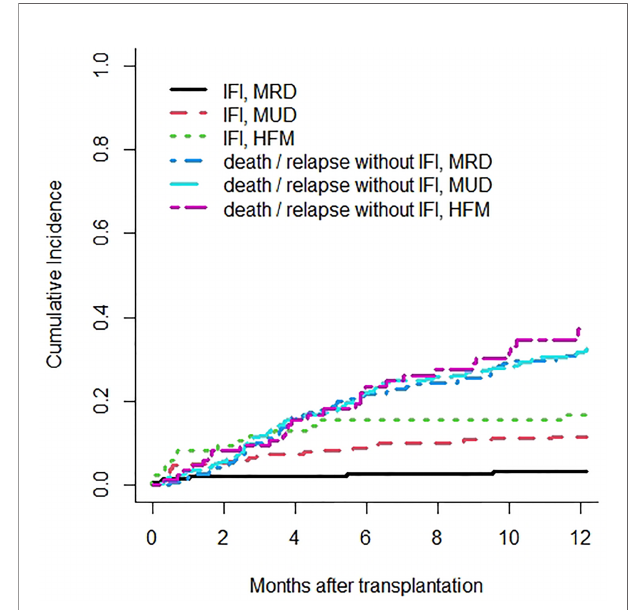
FIGURE 2 | Cumulative incidence rates of invasive fungal infections (IFIs) are 3.2% in matched related donor (MRD), 11.4% in matched unrelated donor (MUD), and 16.8% in haploidentical family member (HFM) transplants. Death or relapse without IFIs are considered the competing event.